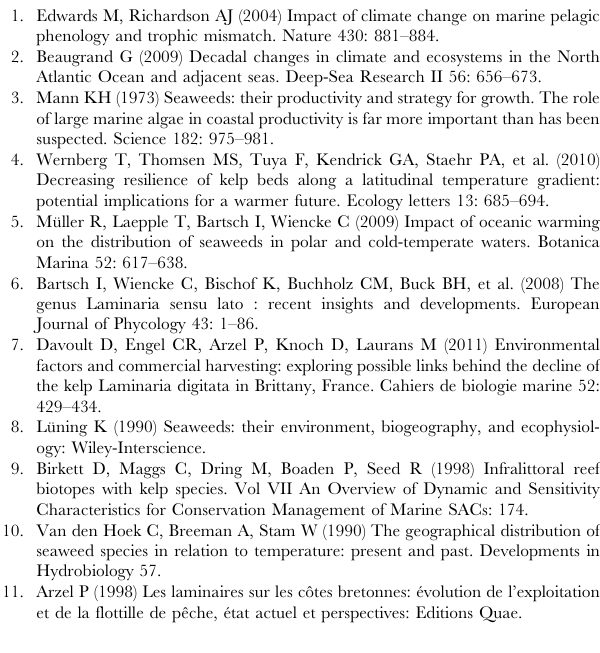
Figure 5. Projections of short-term (2010–2019) and long-term (2050–2059) changes in the spatial distribution of the probability of occurrence of L.digitata in Europe calculated from NPPEN model and based on maximum annual SST estimated by the MPI-ESM-LR model. a, mean probability of occurrence for the period 2010–2019 based on maximum SST assessed from the scenario RCP2.6. b, mean probability of occurrence for the period 2010–2019 based on maximum SST assessed from the scenario RCP8.5. c, mean probability of occurrence for the period 2050–2059 based on maximum SST assessed from the scenario RCP2.6. d, mean probability of occurrence for the period 2050–2059 based on maximum SST assessed from the scenario RCP8.5. Colored white geographical cell denotes a nil probability. The colorbar indicates the probability of occurrence of L. digitata .